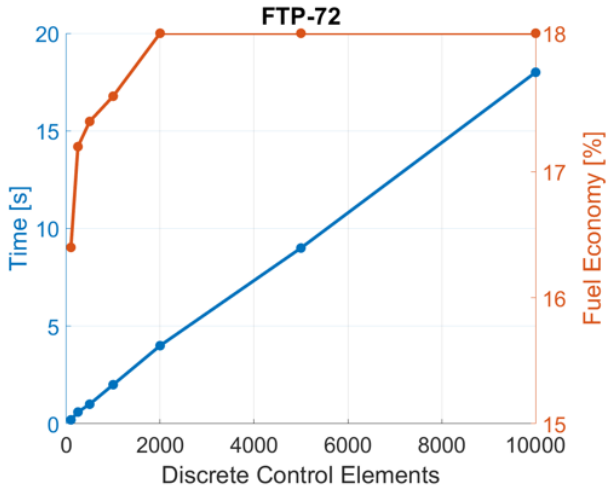
Figure 3. Influence of the number of the discrete control elements Q on computational time per iteration and fuel economy achieved through PMP on the FTP-72 driving cycle.